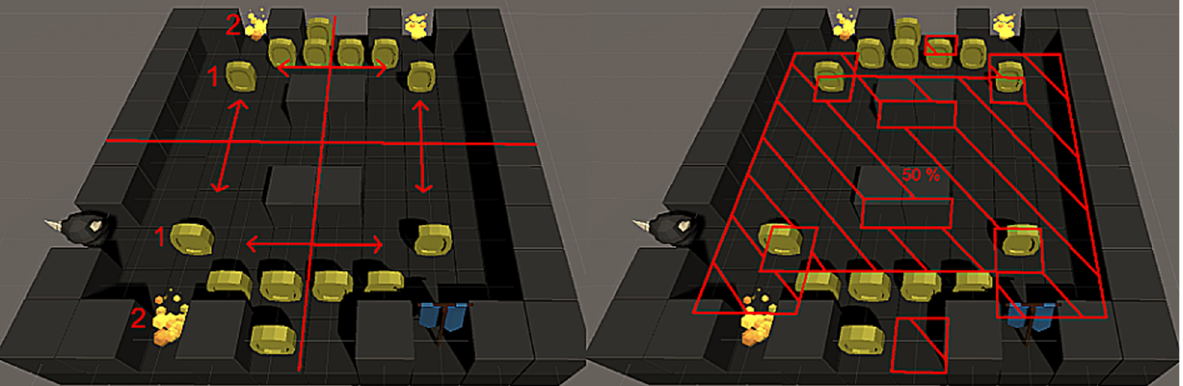
Figure 14. Symmetry and empty space balance. The numbers ‘1’ and ‘2’ represent the corresponding symmetrical objects. ‘50%’ represents the balance between the number of objects and the empty space.